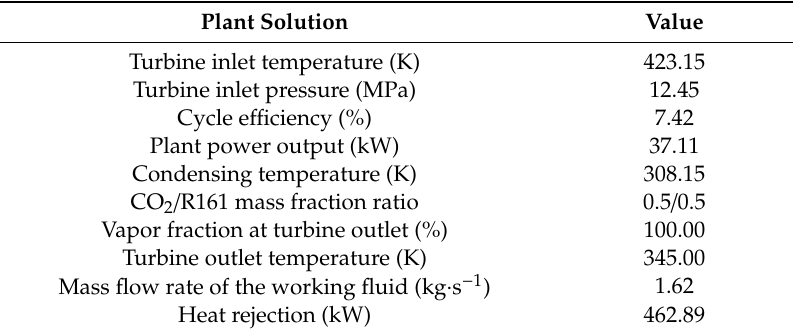
Table 5. Design conditions for the air-cooled CO 2 / R161